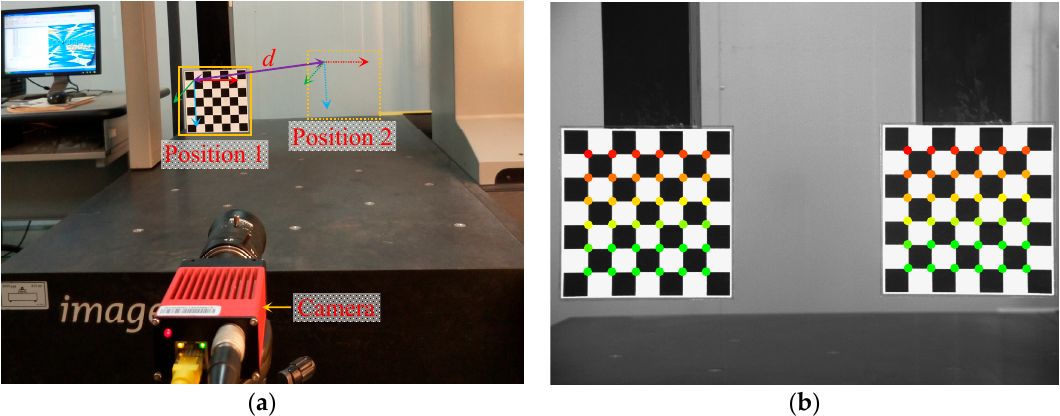
Figure 12. Experiment for measuring displacement. ( a ) Determining d via CMM and camera. ( b ) A merged image of two positions with located corners.